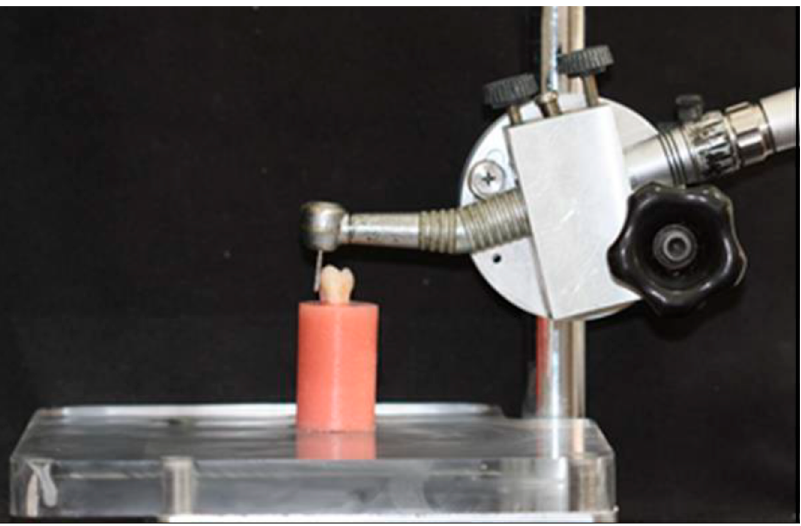
Figure 4. Surveyor-like apparatus for the standardized preparation of mounted extracted teeth.